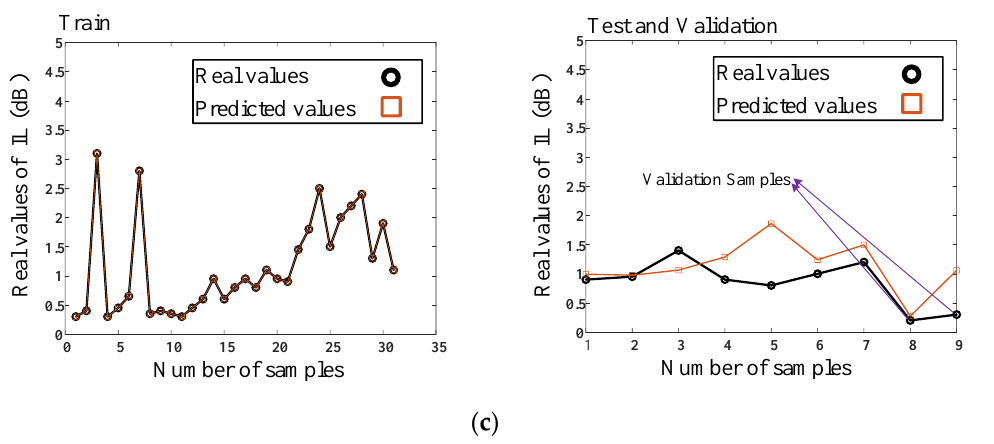
Figure 7. Real and predicted test and train values of ( a ) f 0 (GHz), ( b ) BW (MHz), and ( c ) IL (dB) parameters versus number of data samples in the proposed model. Table 1. The real data of train, test, and verification procedures, using the proposed